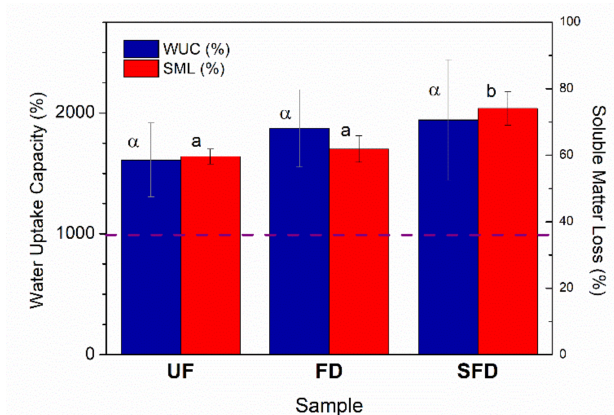
Figure 7. Water uptake capacities of porcine plasma protein-glycerol materials using UF, FD, or SFD protein systems, obtained through deionized water immersion over 24 h. The dashed line indicates the superabsorbent threshold. Average values marked with different lower-case Greek letters are statistically different ( p <